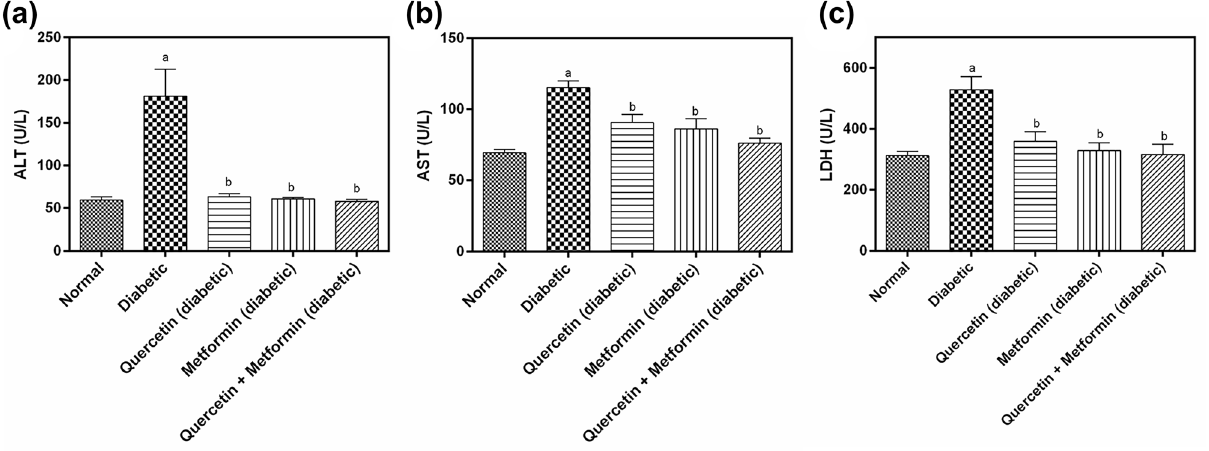
Figure 2. Effect of test compounds on, ( a ) plasma alanine aminotransferase (ALT), ( b ) plasma aspartate aminotransferase (AST), ( c ) plasma lactate dehydrogenase (LDH) in diabetic rats. Data represent mean ± SEM. The alphabet, ‘a’ shows a significant difference in comparison with normal control ( p < 0.05). The alphabet, ‘b’ shows a significant difference in comparison to diabetic control ( p <